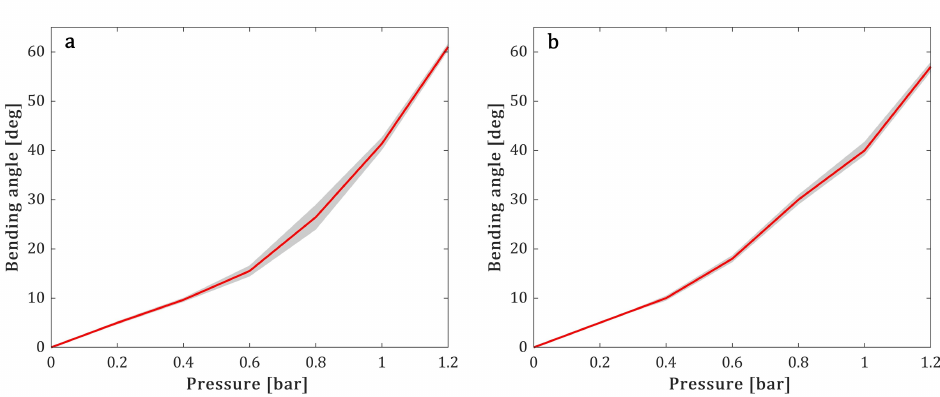
Figure 7. Experimental results for the angular workspace obtained through the activation of a single pair of chambers of the ( a ) FJ module and of the ( b ) LMPA